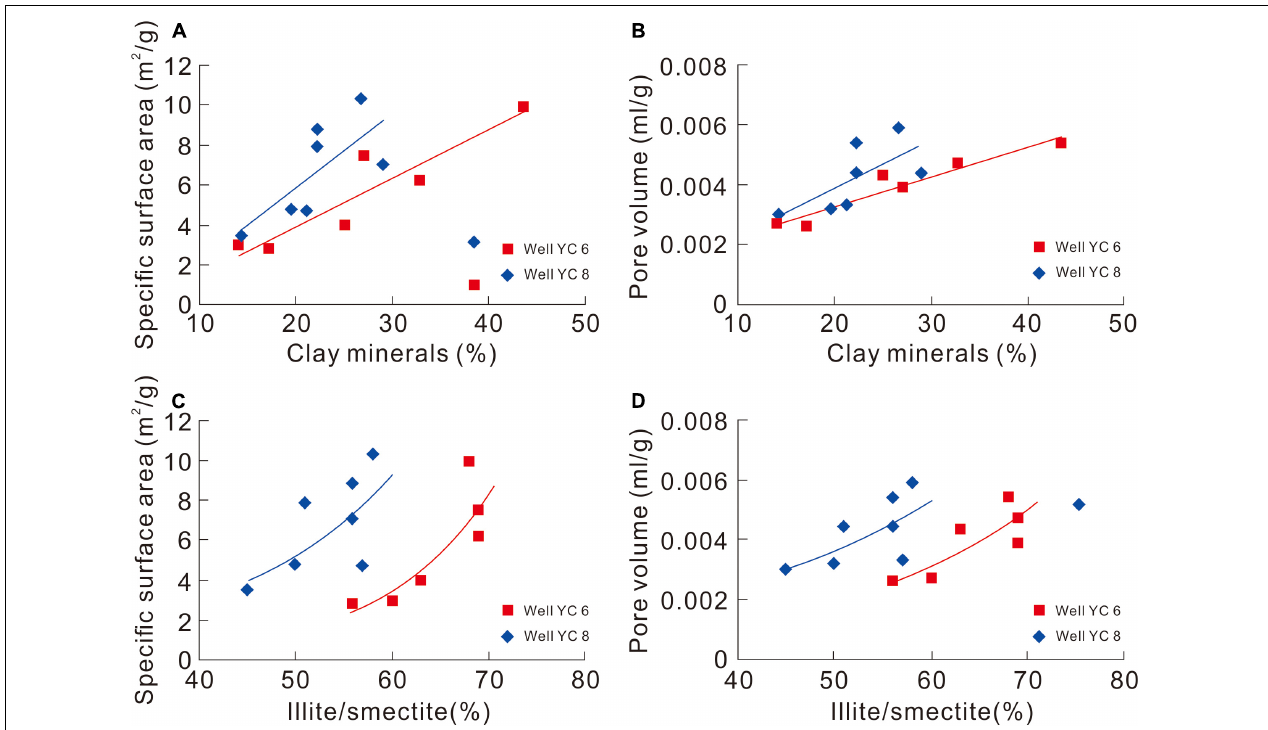
FIGURE 12 | (A,B) Correlation diagram of the clay mineral content, specific surface area, and pore volume of the Longmaxi Formation shale in southeastern Chongqing; (C,D) correlation diagram of the mineral content, specific surface area, and pore volume of the shale illite/smectite layer of the same